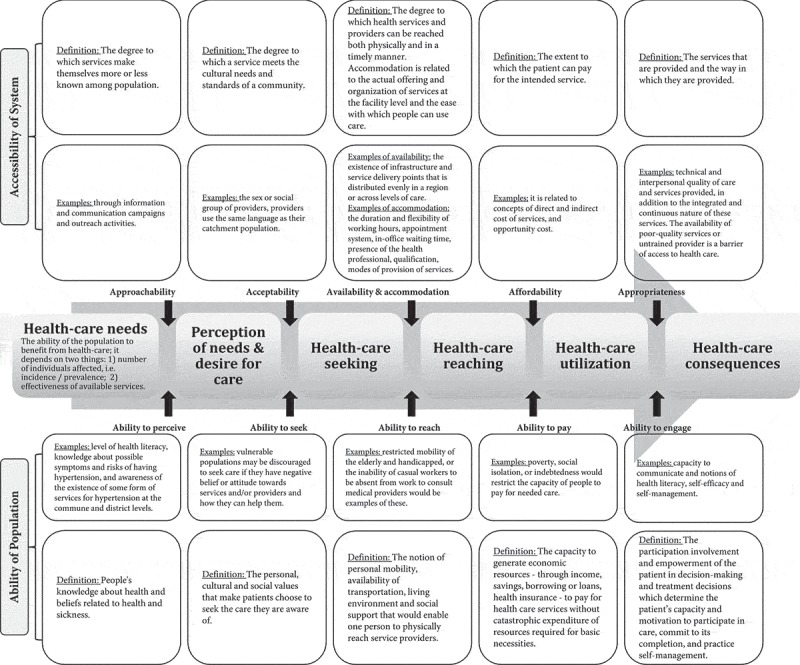
Framework on people-centred access to health care with definitions and examples for each component, modified from Levenseque [24].